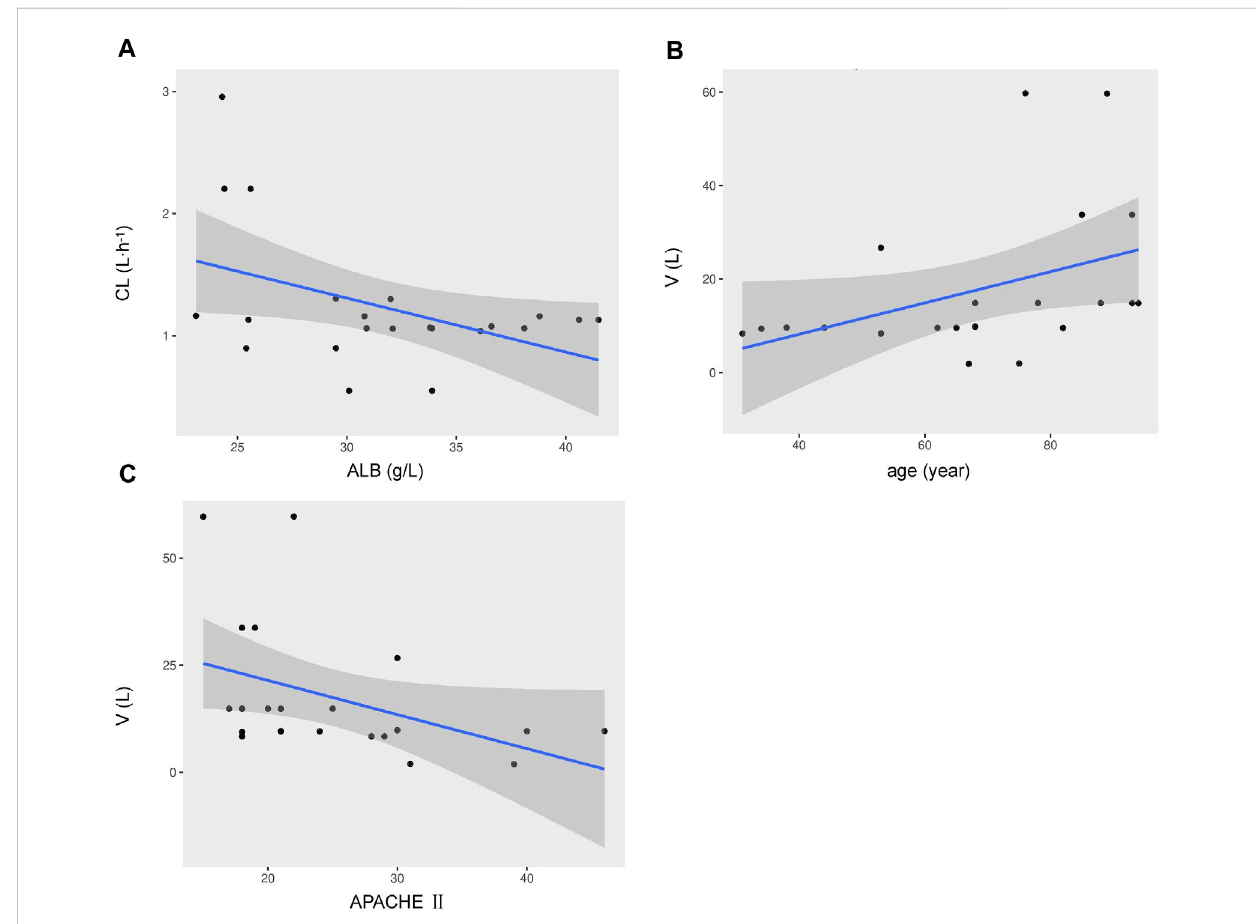
FIGURE 1 Covariates relationshipusingatwo-compartment base model ofindividualpolymyxinBapparent clearanceestimatesversusALB (A) , thevolume of distribution versus age (B) , the volume of distribution versus APACHE-II scores (C) . Shadow area, 95% con fi dence interval.